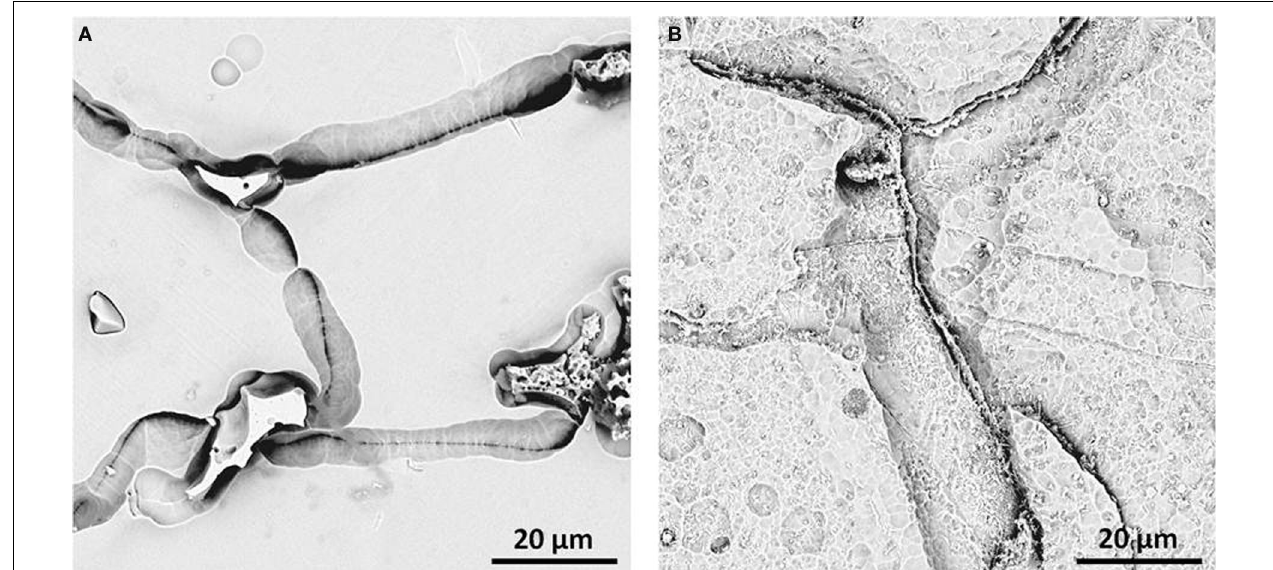
FIGURE 5 | Microstructure of laser processed Co-Cr-Mo alloy after corrosion testing (A) S7, solutionized at 1200°C for 60min, no aging; (B) S9, solutionized at 1200°C for 60min, aged for 4h at 830°C .